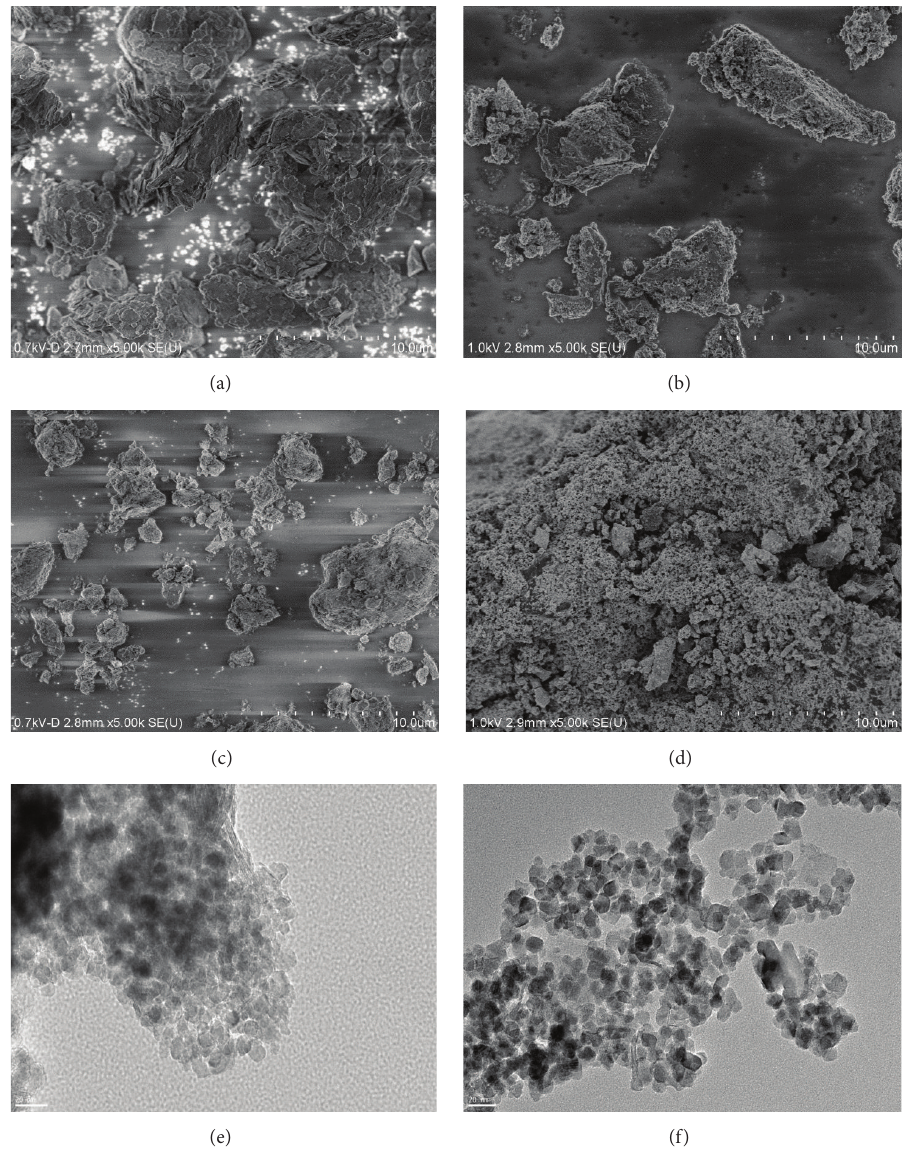
Figure 2: SEM images of (a) NC, (b) AC, (c) TiO 2 /NC, and (d) TiO 2 /AC and TEM images of (e) TiO 2 /NC and (f) TiO 2